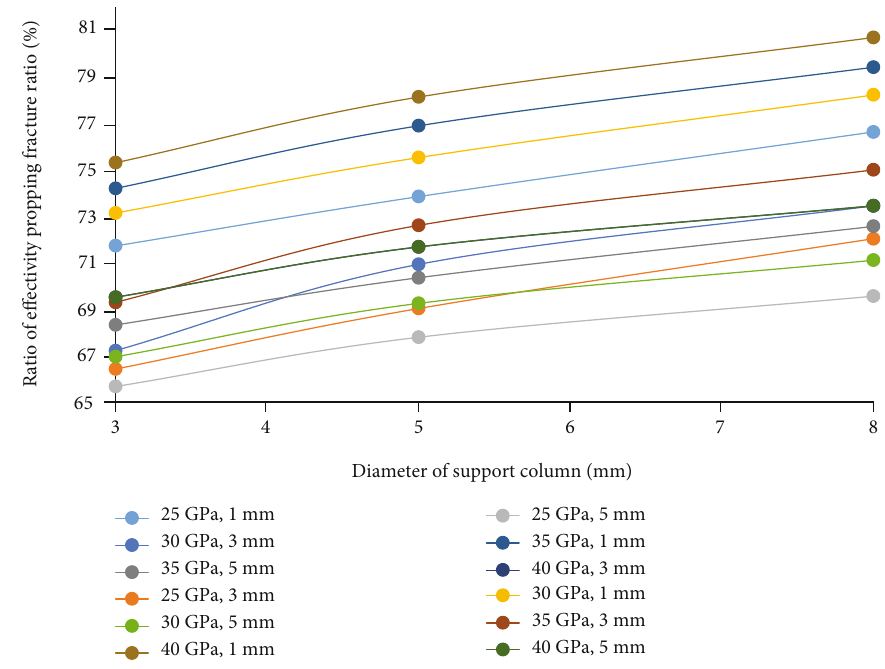
Figure 49: The e ff ect of proppant height on the ratio of e ff ective propped fractures under 40 MPa in situ stress and di ff erent elastic moduli.